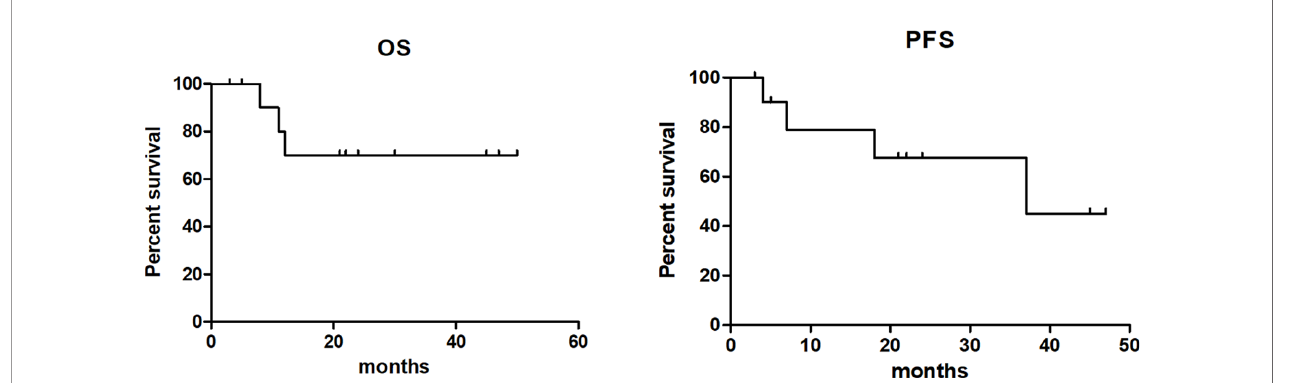
FIGURE 5 | Overall survival and progression-free survival of patients after anti-CD30 CAR-T